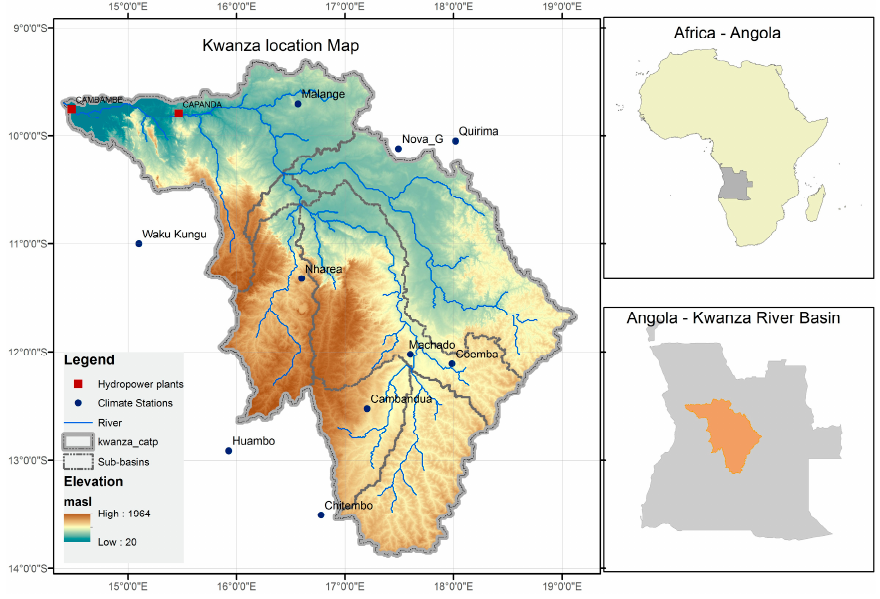
Figure 1. Location map of Kwanza River Basin, Angola.